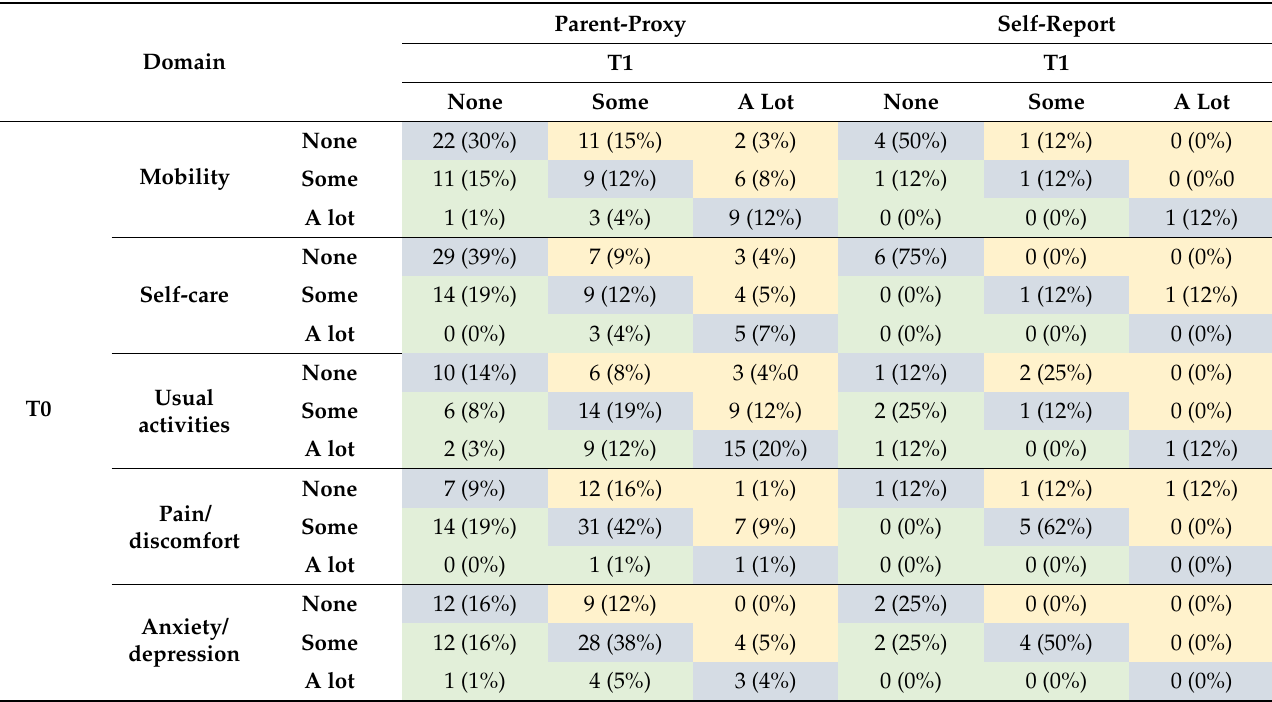
* Among parents/patients who responded at both timepoints. T1; ficulties at T1.